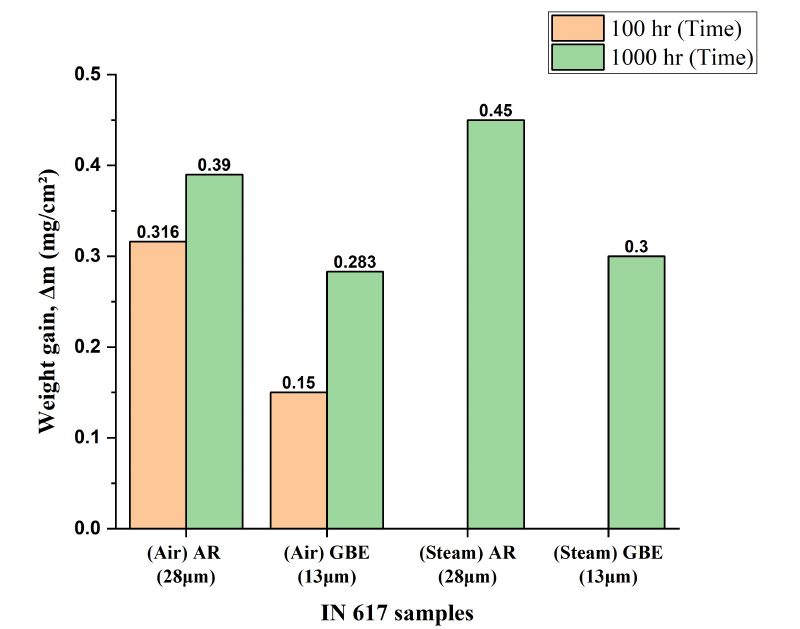
Figure 5. Weight gain of samples with different grain size under air and steam